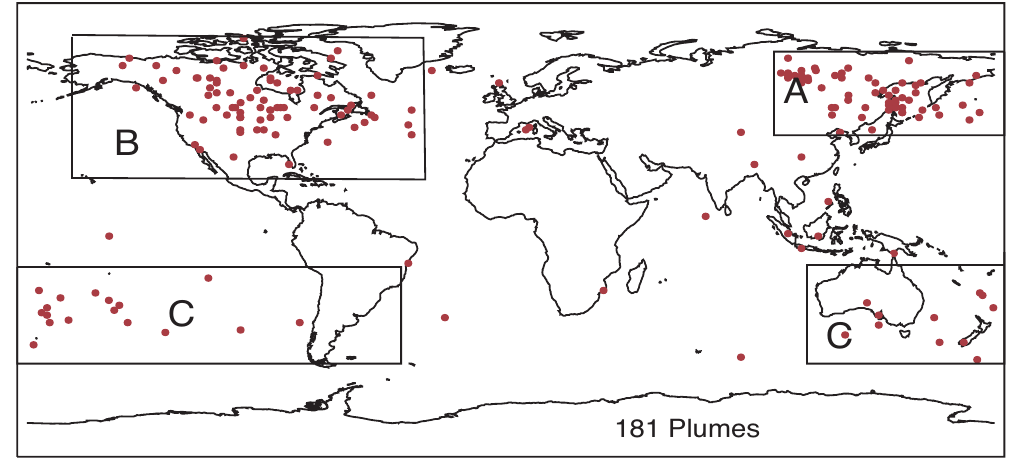
Fig. 5. Global distribution of high-altitude plumes with an AI value ≥ 9 (i.e. height ≥ 5km) during the entire AI data record (31 October 1978 to 13 February 2009). 181 plumes were identified, and 163 of those are located in these three main regions.